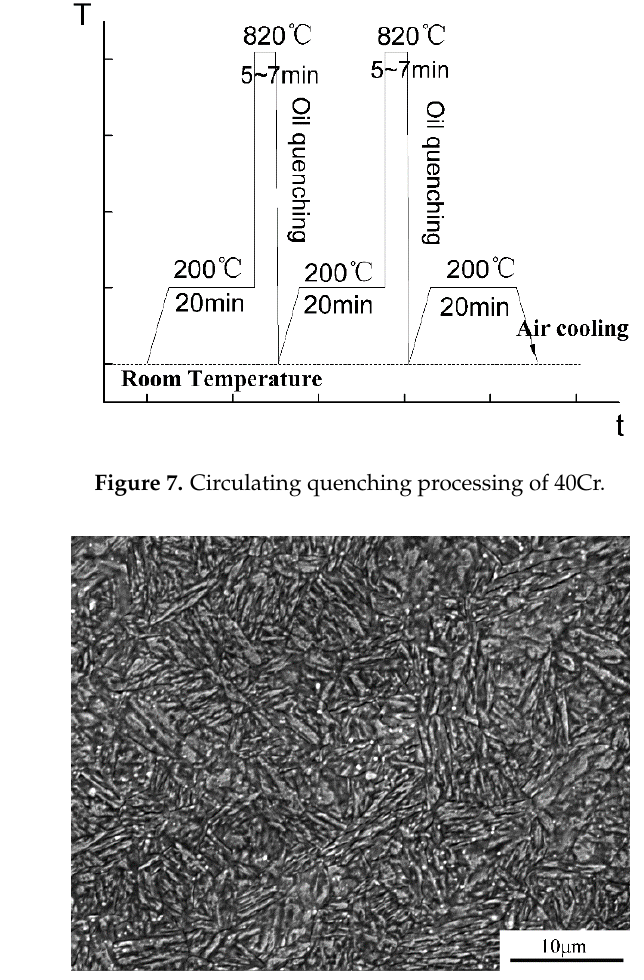
Figure 8. Microstructure of 40Cr steel after ultra ‐ fine treatment.